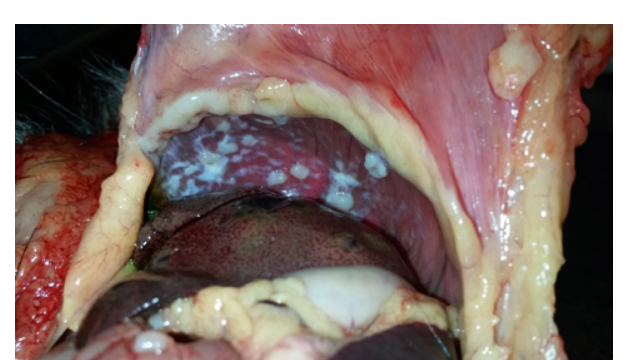
Supplementary Figure 1: Macroscopic image of the Southern African hedgehog tissues examined at autopsy showing multifocal proliferative to plaque-like neoplastic lesions on the peritoneal surface of the diaphragm.